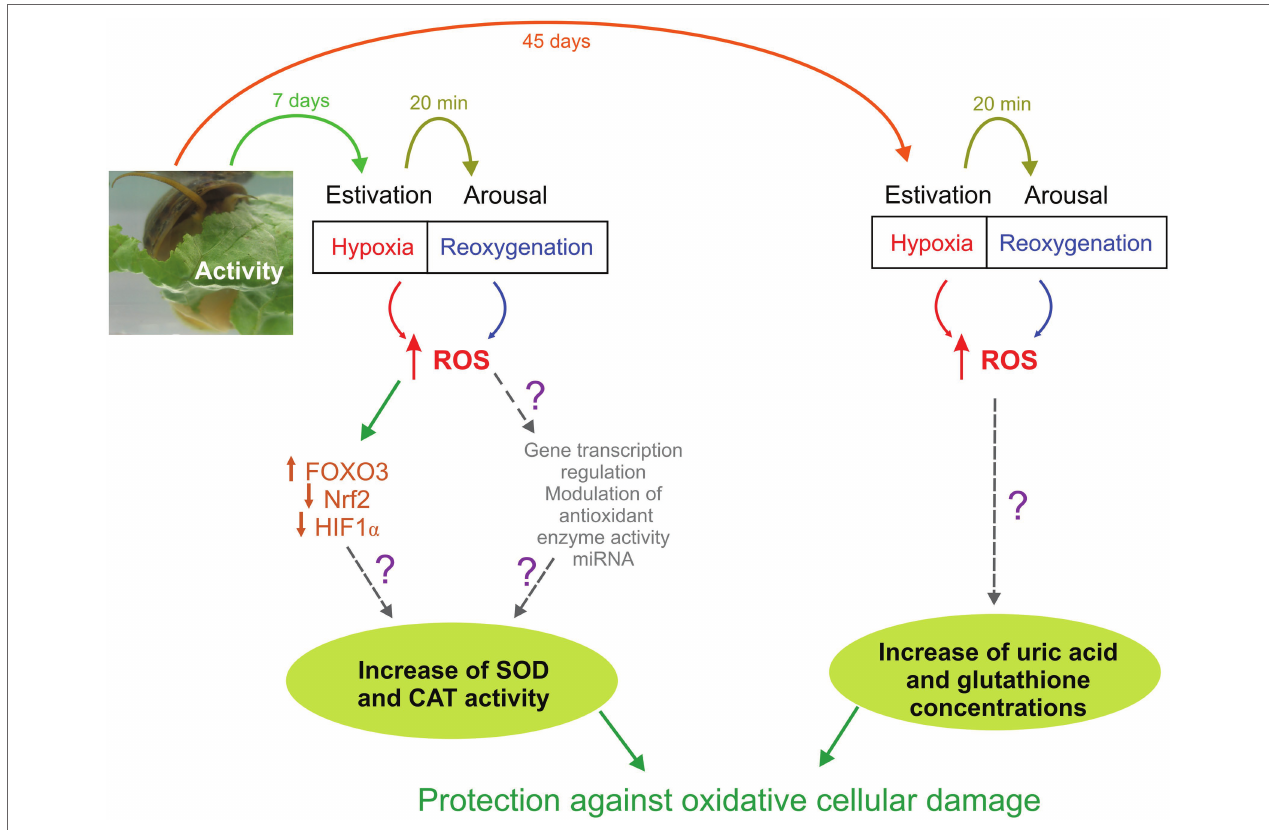
FIGURE 2 | Schematic representation of Pomacea canaliculata responses to different periods of estivation (7 and 45 days). Unknown mechanisms have been represented with a question